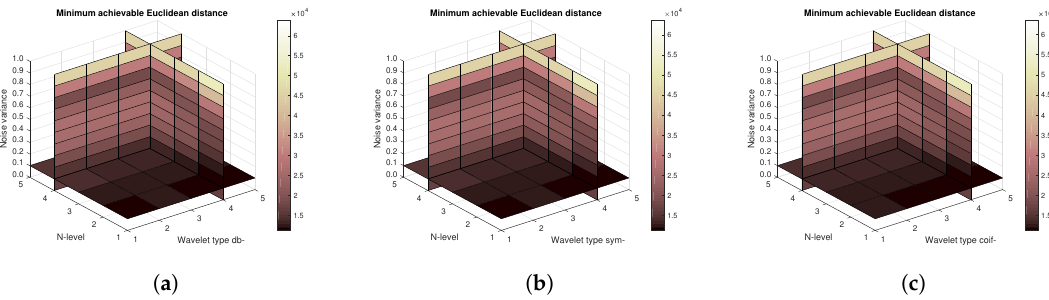
Figure 16. Mean achievable Euclidean distances for 15 CT images from 5 patients with use of three mother wavelet families – from left Daubechies ( a ), Symlet ( b ) and Coiflet ( c